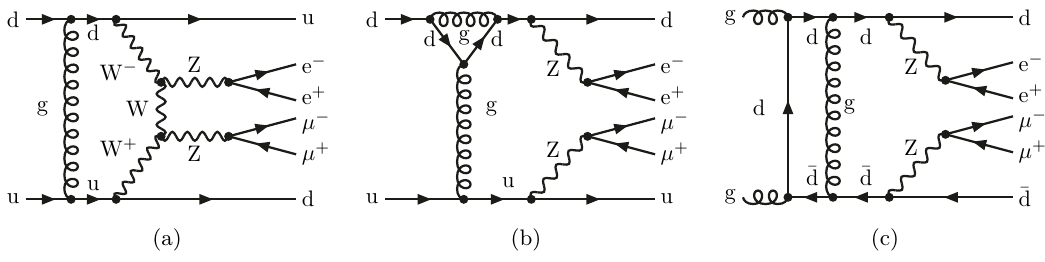
Figure 3 . Examples of virtual one-loop Feynman diagrams: mixed EW–QCD loop (left) and purely QCD loops (middle and